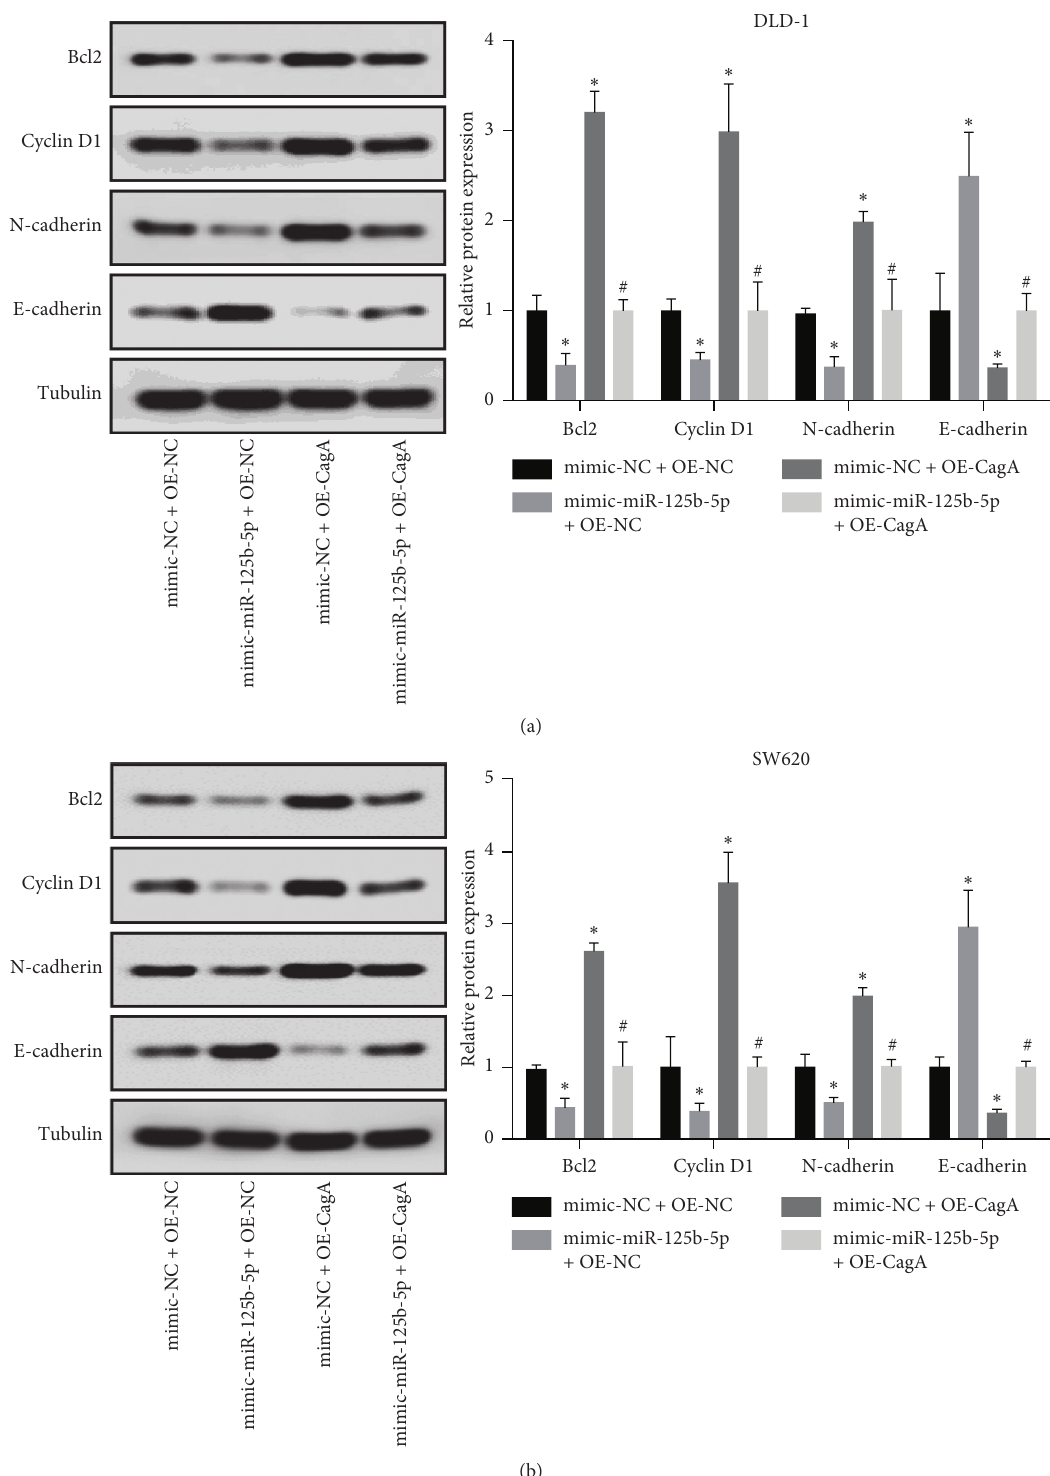
Figure 4: CagA overexpression promotes the proliferation and invasion of colon cancer cells by inhibiting miR-125b-5p. (a) and (b) represent the transfection of CagA plasmid increased the expression of the apoptosis-related protein Bcl2, the proliferation-related protein cyclin D1, and the invasion-related protein N-cadherin but decreased the expression of E-cadherin, while transfection of miR-125b-5p had the opposite effect and reversed the effects of CagA on Bcl2, cyclin D1, N-cadherin, and E-cadherin in both DLD-1 (a) and SW620 (b) cells. ∗ p < 0 . 05, compared with mimic-NC+OE-NC, and # p < 0 . 05, compared with mimic-NC+OE-CagA